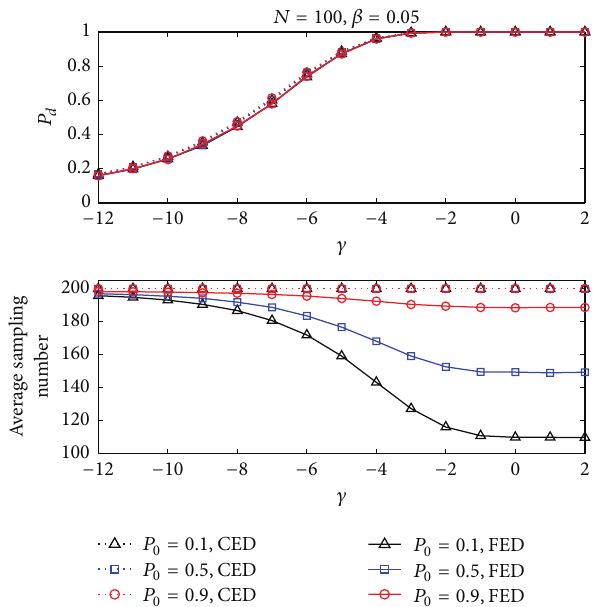
Figure 6: Performance of CED and FED versus 𝛾 under different 𝑃 0